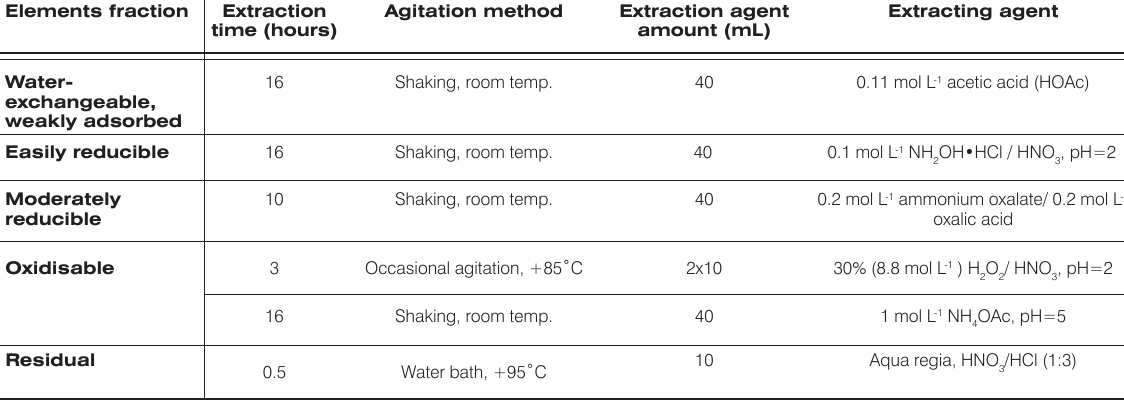
Table 1. Experimental conditions for sequential extraction procedure. Elements fraction